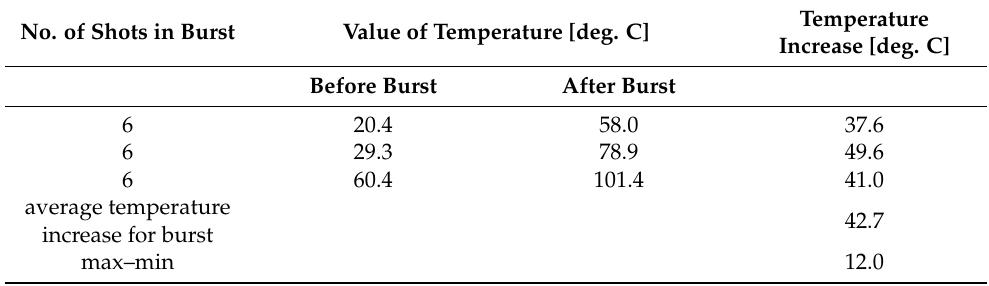
Table 4. Results of temperature